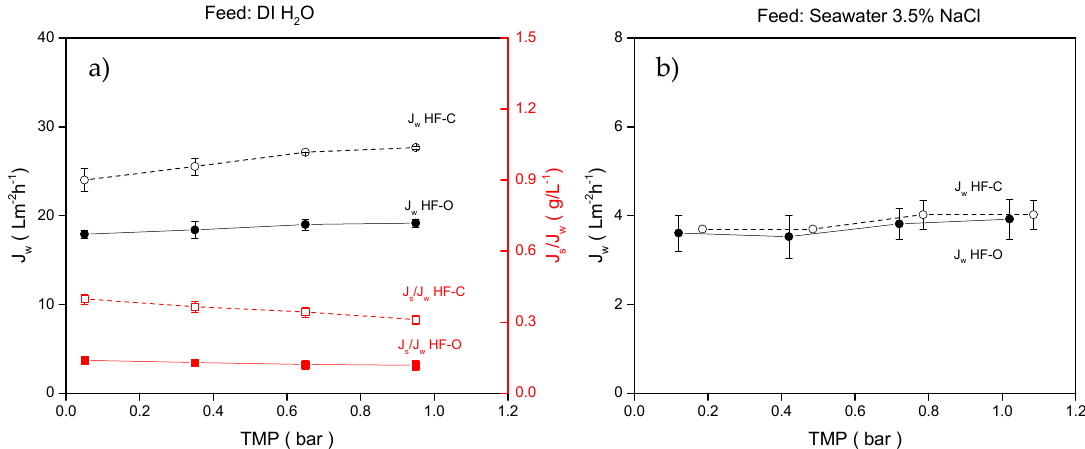
Figure 8. ( a ) J w and J s / J w for HF–C and HF–O modules as a function of applied TMP when DI water was used as an FS; ( b ) J w for HF–C and HF–O modules as a function of applied TMP when 3.5% NaCl was used as an FS. Feed flow rate was 100 L · h − 1 , draw flow rate was 25 L · h − 1 , and draw concentration was 1 M NaCl. (n =